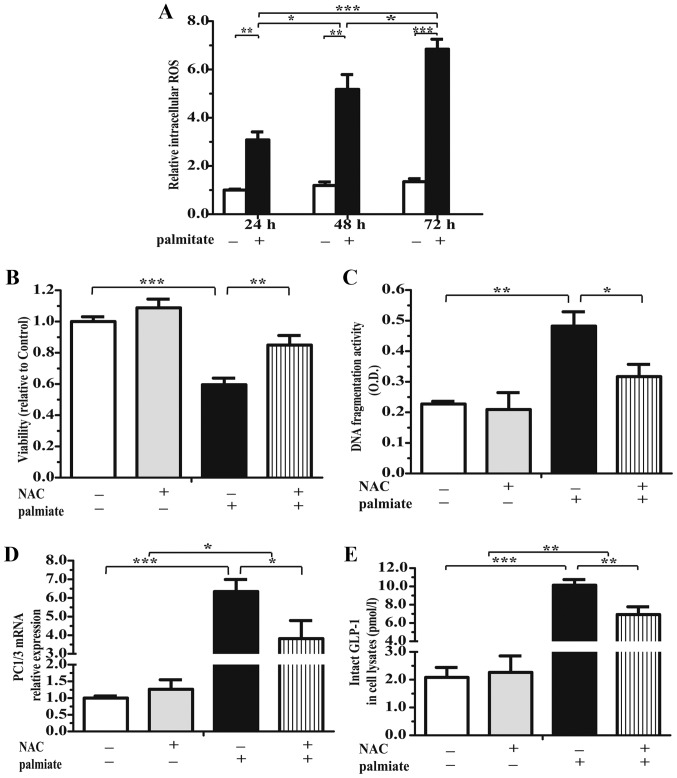
Prolonged exposure to palmitate induces reactive oxygen species (ROS) productin and activates the glucagon-like peptide-1 (GLP-1) system. (A) Following incubation with 0.5 mmol/l palmitate for the indicated periods of time, ROS levels were detected by DCFH-DA. Following pre-incubation with 5 mmol/l N-acetylcysteine (NAC) for 48 h, cell (B) viability (by MTT assay) and (C) apoptosis (by examining histone-associated DNA fragments), and (D) prohormone convertase 1/3 (PC1/3) mRNA (by qPCR) and (E) GLP-1 levels (by ELISA) in the cell lysates were determined. n=3 separate isolated islet preparations; *p<0.05; **p<0.01; ***p<0.001.